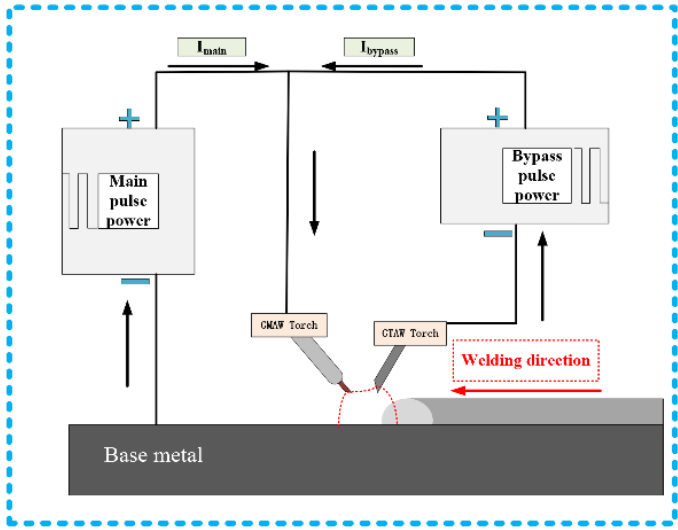
Figure 1. Schematic diagram of a welding system.